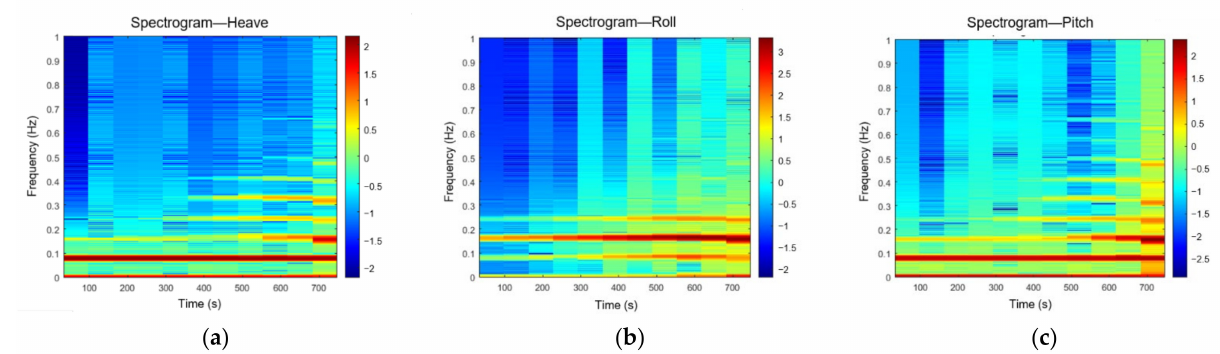
Figure 9. FFT plots of the case HB001HA100_SS06WA135 : ( a ) FFT plot for heave, ( b ) FFT plot for roll, and ( c ) FFT plot for pitch.